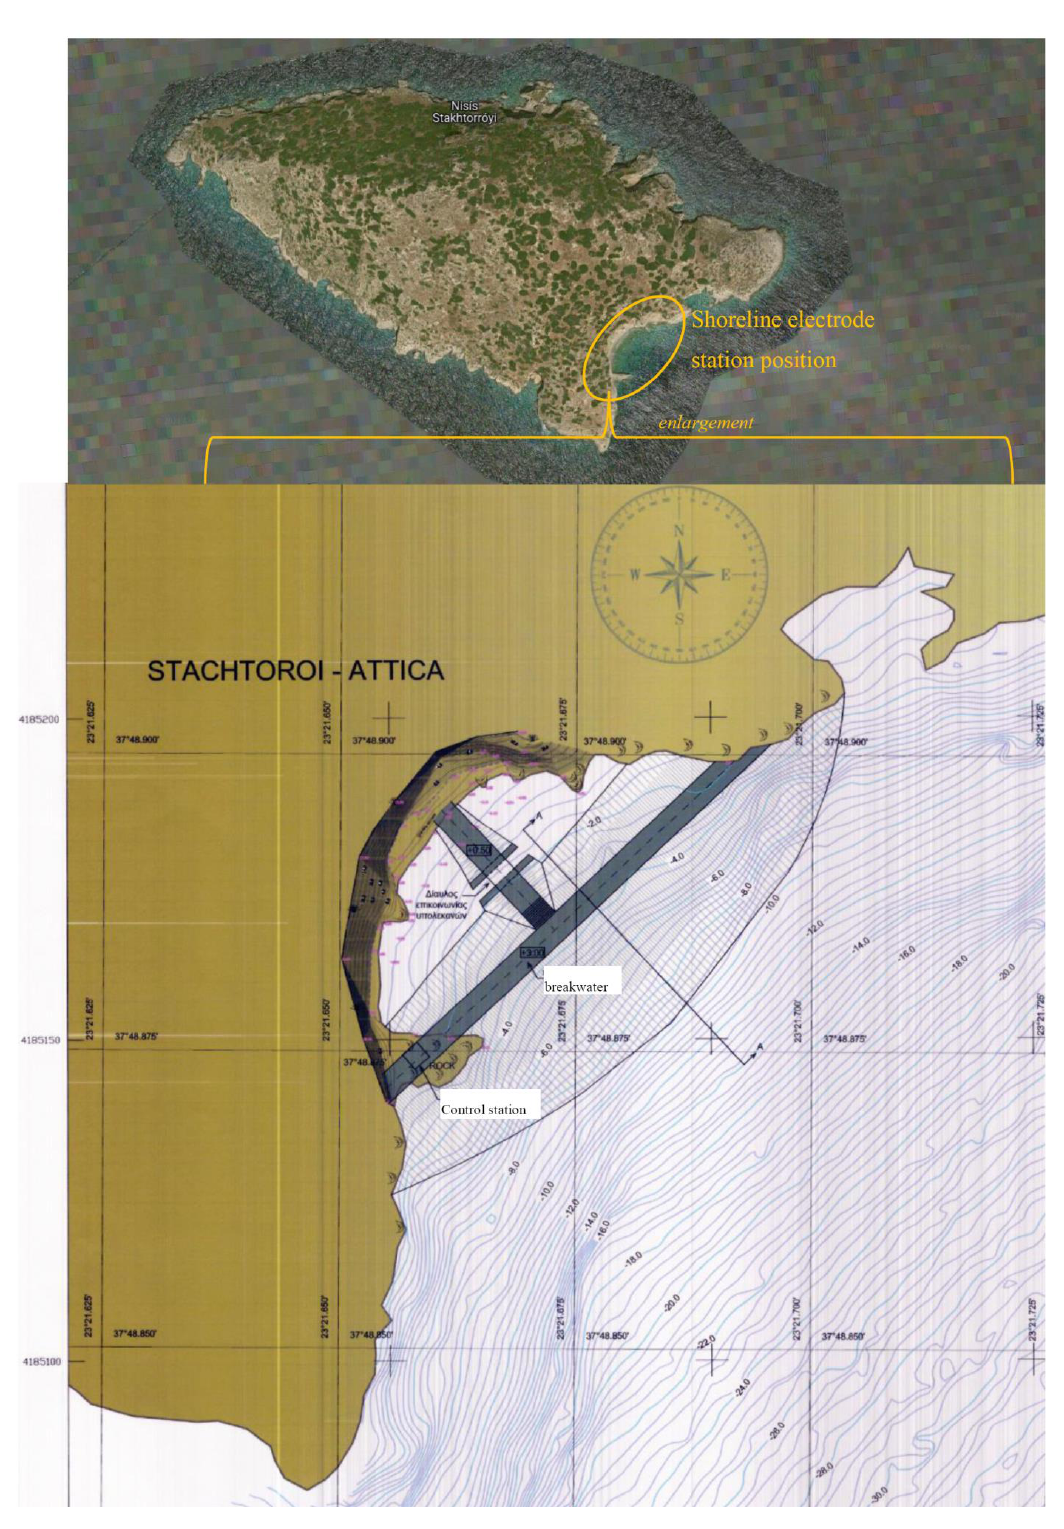
Figure 11. Shoreline electrode station on the islet of Stachtoroi, in the Argosaronic gulf, in the region of Attica